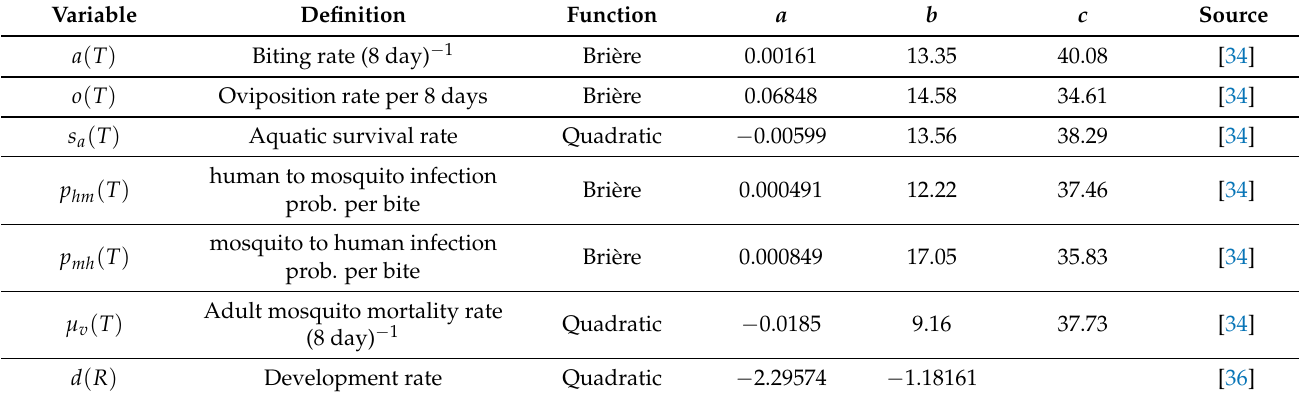
Table 2. Temperature- and rainfall-dependent responses for Aedes aegypti biological traits. Traits were noted as Brière [ aT ( T